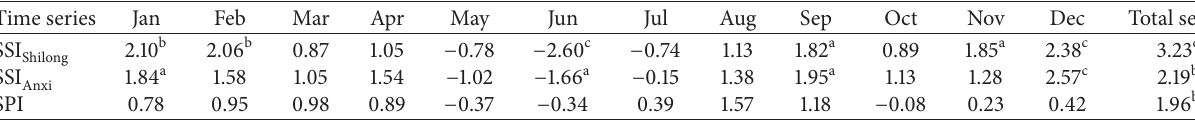
Table 2: Statistics of M-K for SSI and SPI on monthly time scales.